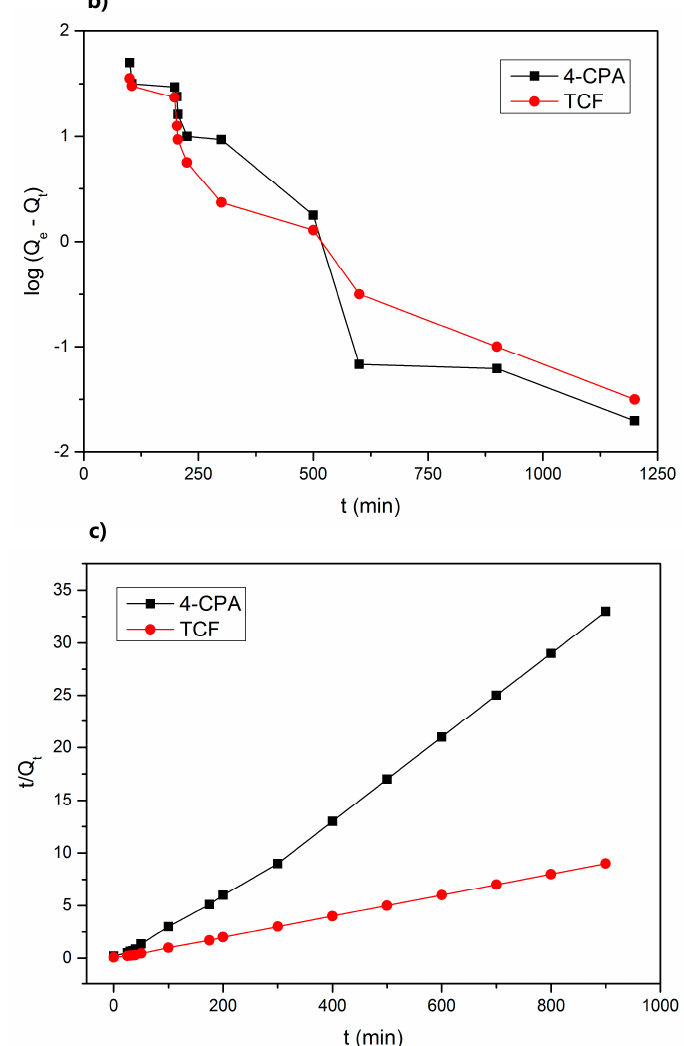
Figure 7. Plots of the sorption kinetics ( a ), pseudo-first order kinetics ( b ), and pseudo-second order kinetics ( c ) for both pesticides.